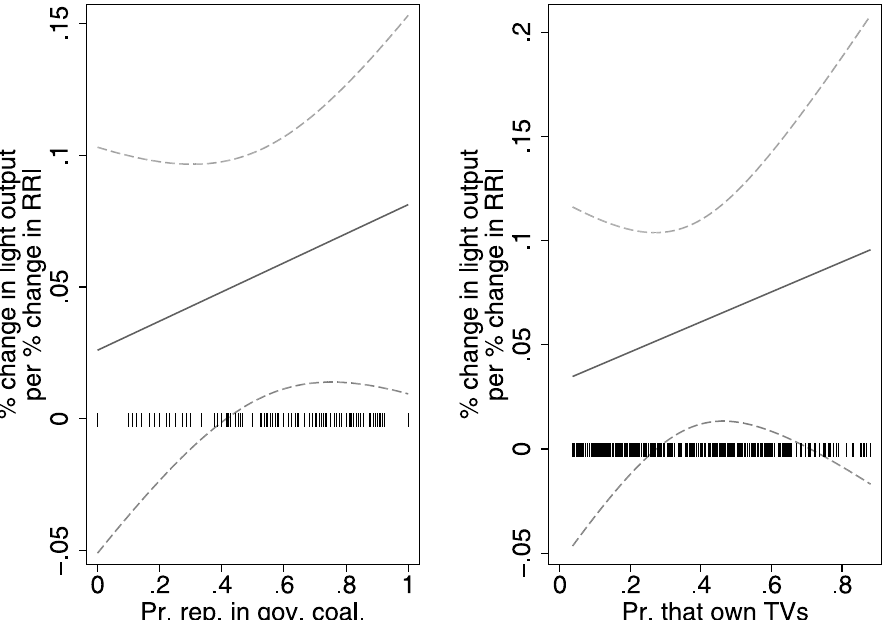
Fig 4. The effect of malapportionment on light output as the proportion of representatives in the governing coalition and those that own TV vary, with 95% confidence intervals. The coefficients underlying the plots are from the two regressions in S6 Table. The rug plots display the distribution of proportion of representatives in the governing coalition, and the proportion of the rural population that own TVs. See text for details.